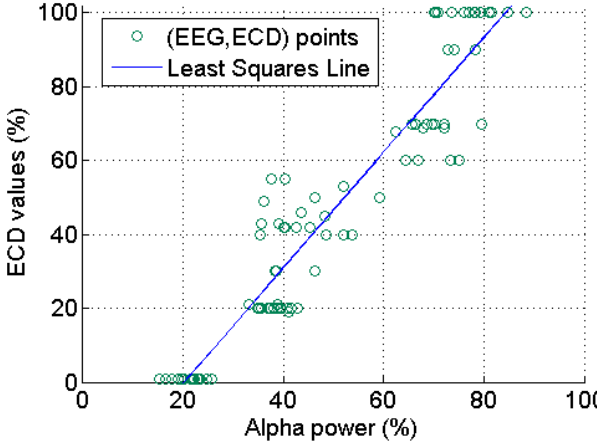
Figure 11. The simple linear regression model with slope β ˆ (= 1.560) and intercept 2 = α ˆ (= − 31.370) from a representative subject ( R